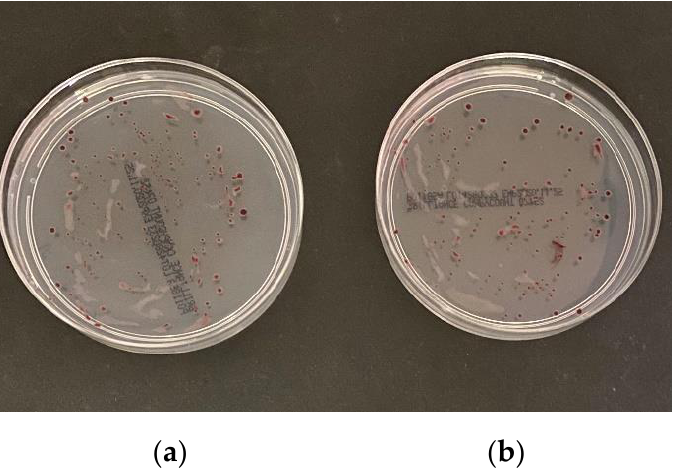
Figure 4. Campylobacter viability . C. jejuni strain was cultivated on Brilliance CampyCount Agar ( a ) before and ( b ) after centrifugation. Transmission electron microscopy was used for the detection of cell morphology, e.g., flagellas of C. jejuni and C. coli before and after high-speed centrifugation (Figure 5). Our results show that 12,000 × g did not damage flagellas in C. jejuni and C. coli ; therefore, they stayed motile without morphologic changes despite high-speed centrifugation.